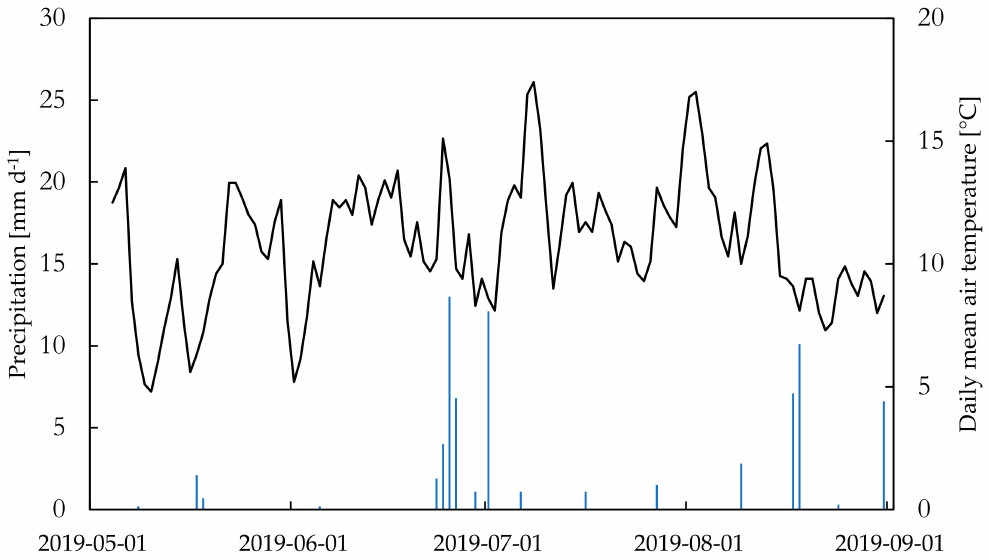
Figure 2. Daily accumulated precipitation (blue bars) and daily mean air temperature (black line) for the 2019 growing season measured at